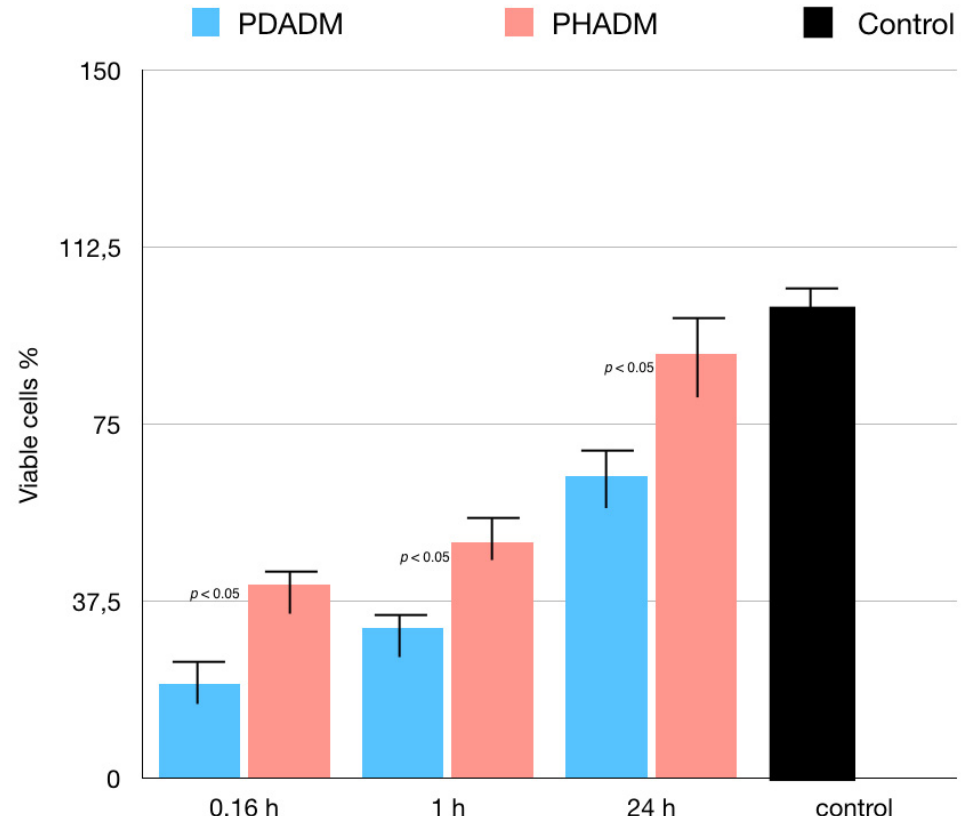
Figure 5. Results of MTT test of HPMSCs cultured in eluates from matrices incubated for 0.16, 1, and 24 h in serum-free cell culture medium. Cells cultured in normal serum-free culture medium served as positive controls. Viable cell % is shown relative to positive controls (least-squared means +/ − 95% confidence intervals). Each column represents the results of the experiments repeated eight times. (One-way analysis of variance (ANOVA) with Tukey’s post-hoc test. Values of p < 0.05 were considered significant.)